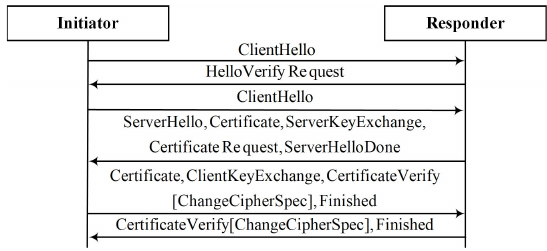
Figure 3. DTLS base